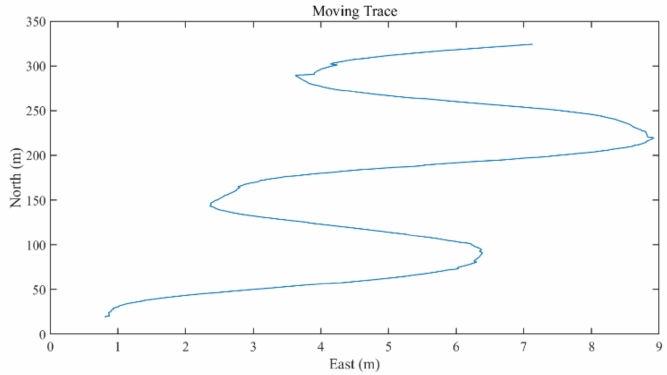
Figure 15. The moving trace of the vehicle at the speed of 30 km/h.